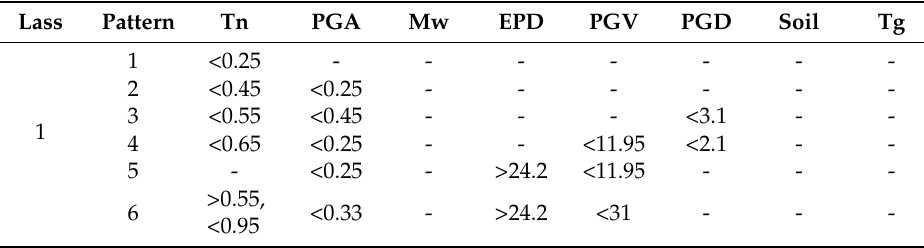
Table 5. Patterns found by the software